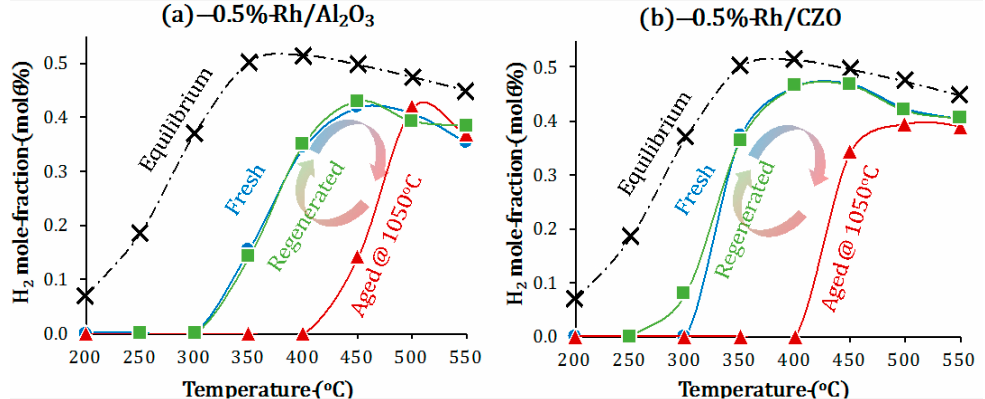
Figure 7 . Activity of fresh, aged, and regenerated ( a ) 0.5% Rh/Al 2 O 3 and ( b ) 0.5% Rh/CZO